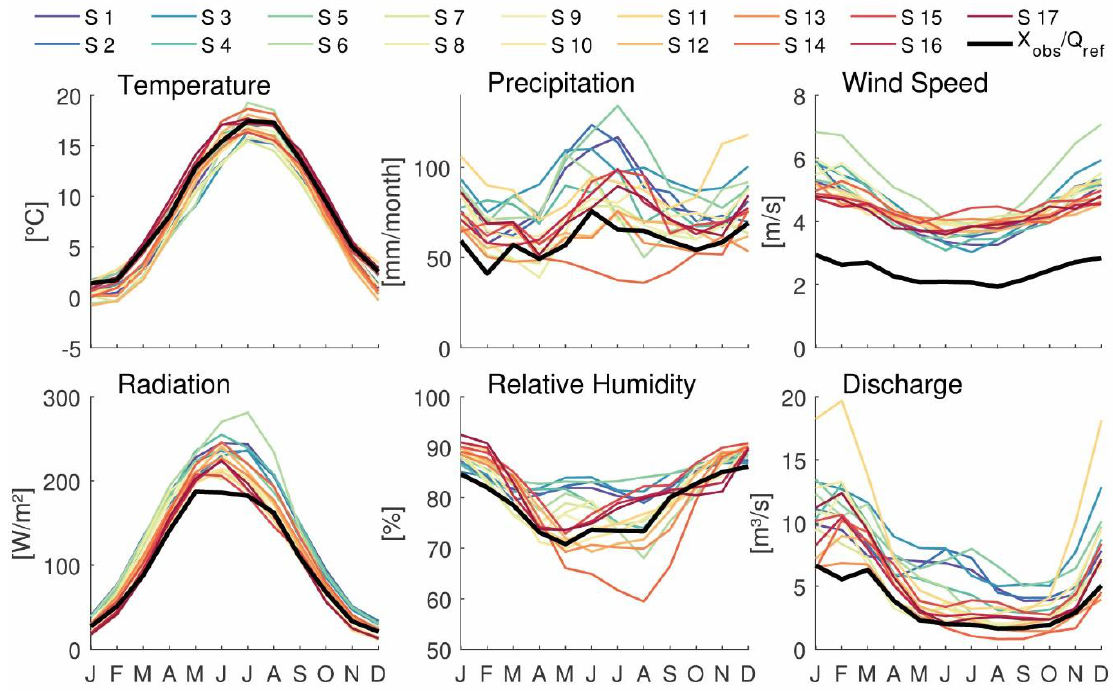
Figure 2. Mean values of climatological and hydrological variables for the catchment Wunstorf for the historical period 1971–2000 for all climate scenarios and observations (X obs ). For discharge, the results of the hydrological modeling with climate scenario data and observational data (Q ref ) are shown.